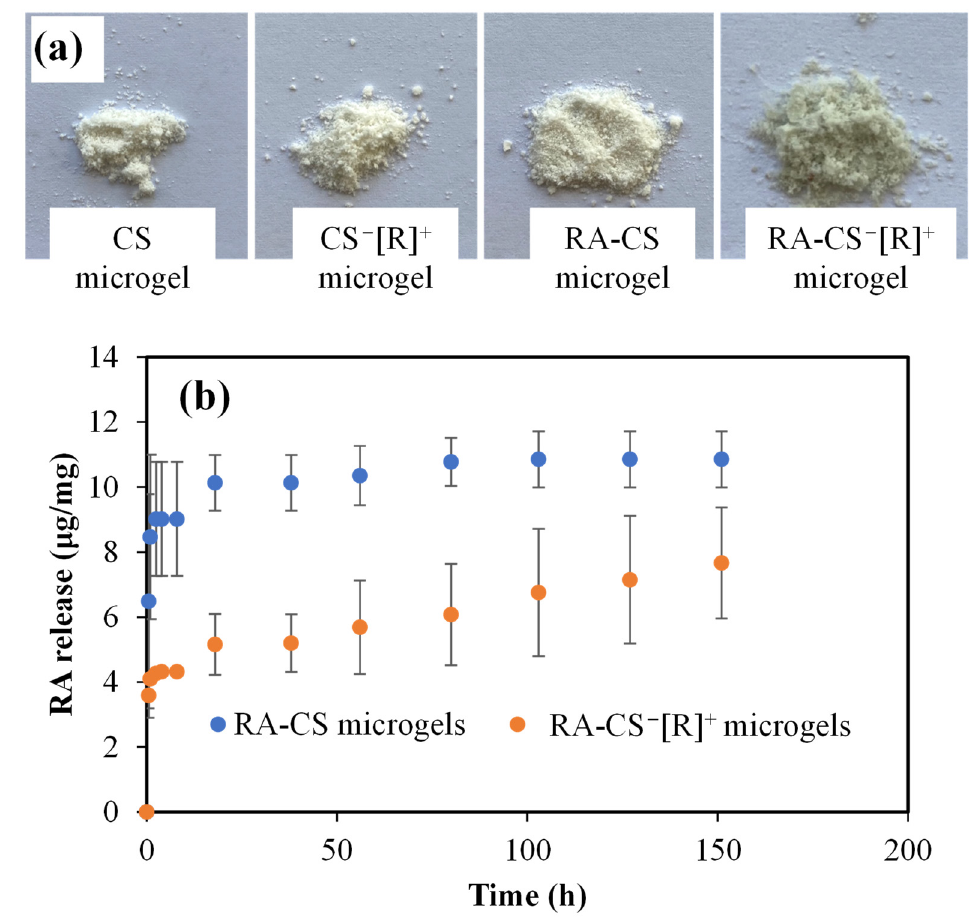
Figure 6. ( a ) Digital camera images of CS microgel and CS − [R] + microgel and their RA-loaded forms. ( b ) RA release profiles of CS and polyelectrolyte CS − [R] + microgels at physiological conditions, pH 7.4 (PBS), and 37 °C.